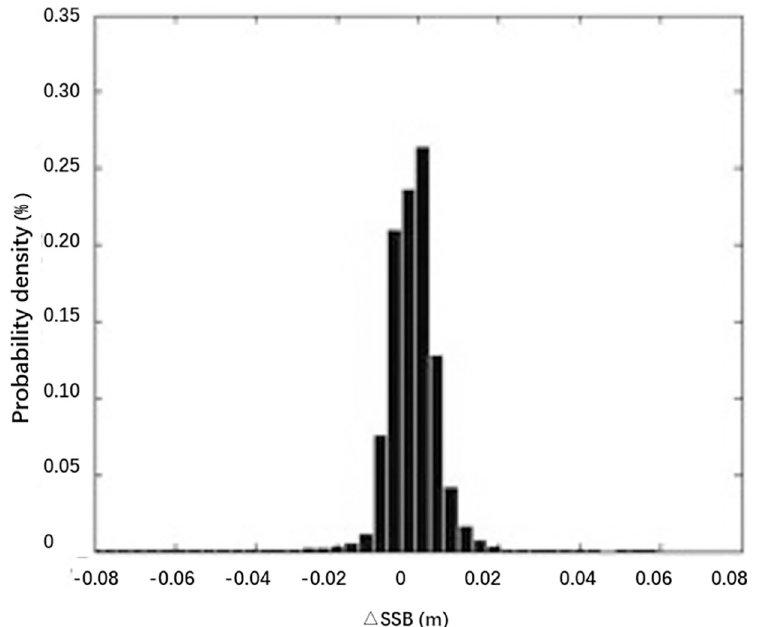
Fig 2. Probability density distribution diagrams of Δ